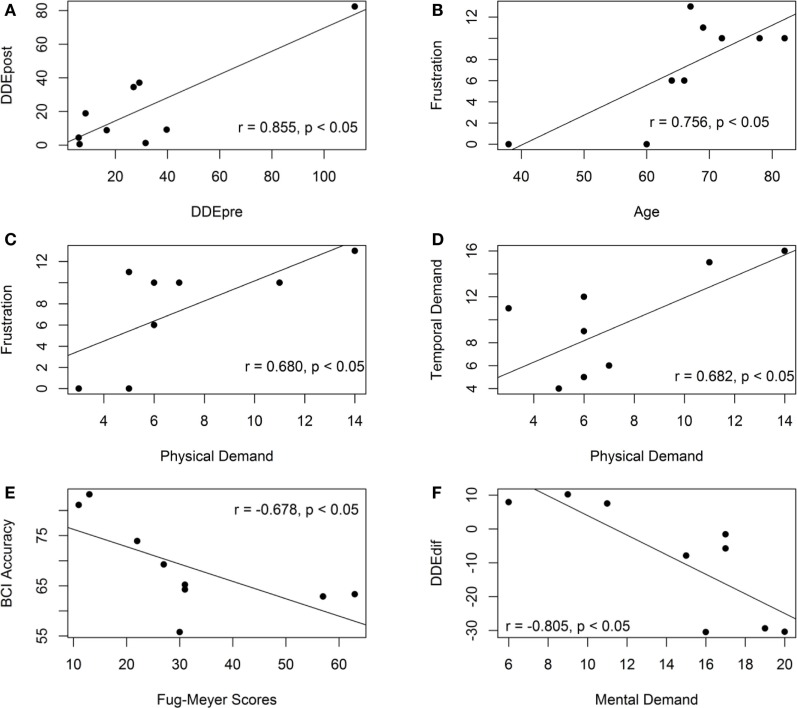
Scatter plots of the variable pairs that demonstrate significant correlation values. (A) The scatter plot of the motor-proprioception ability of the stroke participants before and after the assessment. (B) The scatter plot of the frustration level and age of the stroke participants. (C) The scatter plot of the frustration level and mental demand of the stroke participants. (D) The scatter plot of the temporal and physical demand of the stroke participants. (E) The scatter plot of the BCI accuracy and the Fugl-meyer scores. (F) The scatter plot of the motor-proprioception ability and mental demand of the stroke participants.